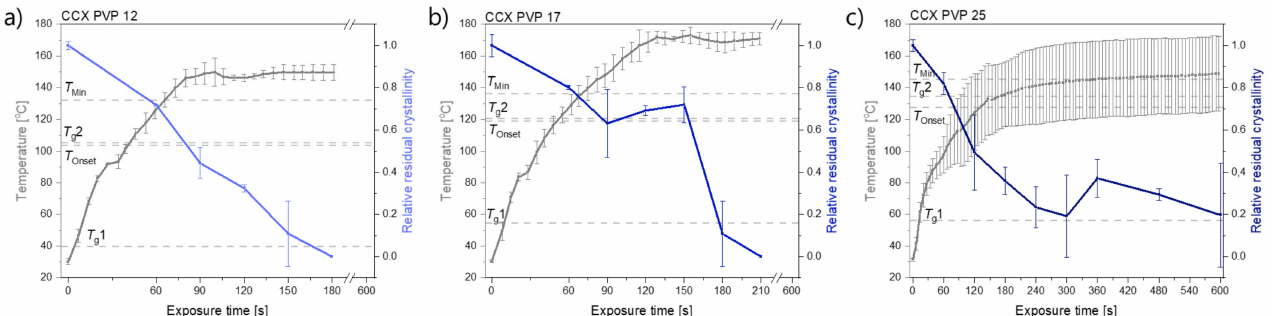
Figure 1. Temperature [ ◦ C] (left y -axis) and relative residual crystallinity (right y -axis, determined by DSC analysis) plotted as a function of exposure time [s]. All compacts were exposed at a laser intensity of 1.52 W/cm 2 . ( a ) Compacts containing CCX and PVP12 (light blue), ( b ) Compacts containing CCX and PVP17 (blue), ( c ) Compacts containing CCX and PVP25 (dark blue). Mean ± SD ( n = 3) for the left y -axis and mean ± SD ( n = 2) for the right y -axis. The horizontal dashed lines indicate the temperatures, T g 1, T g 2, T Onset and T Min , as seen in Table